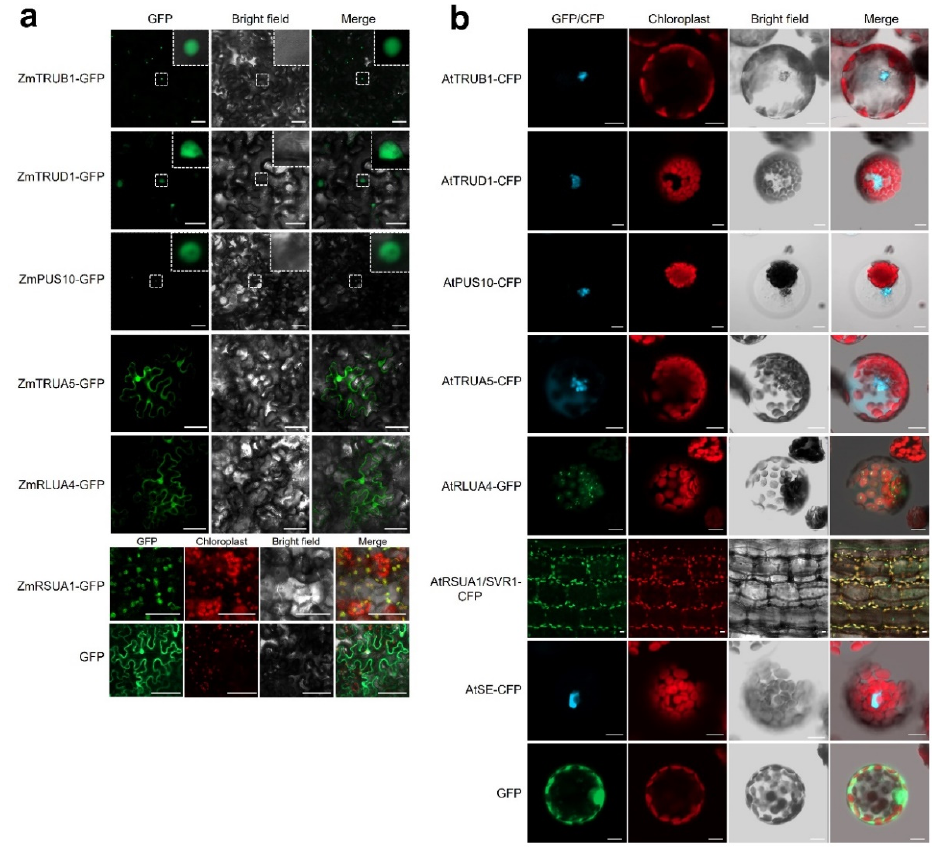
Figure 6. Subcellular localization of the representative proteins in each PUS subfamily. ( a ) Subcellular localization of ZmPUS proteins in the epidermal cells of Nicotinana benthamiana . GFP protein serves as control. Scale bars represent 50 µ m. ( b ) Subcellular localization of AtPUS proteins in Arabidopsis mesophyll protoplasts and the stem of svr1-2/pSVR1-SVR1-CFP transgenic plants. The subcellular localization of AtTRUB1, AtTRUD1, AtPUS10, AtTRUA5, and AtRLUA4 fused with CFP/GFP in C-terminal by PEG transformation-mediated transient expression in Arabidopsis protoplasts. The subcellular localization of AtRSUA1/SVR1 was visualized from the stem of 7-day seedlings in transgenic plants of svr1-2 /pSVR1-SVR1-CFP. AtSE-CFP and GFP only serve as controls. Scale bars represent 10 µ m in